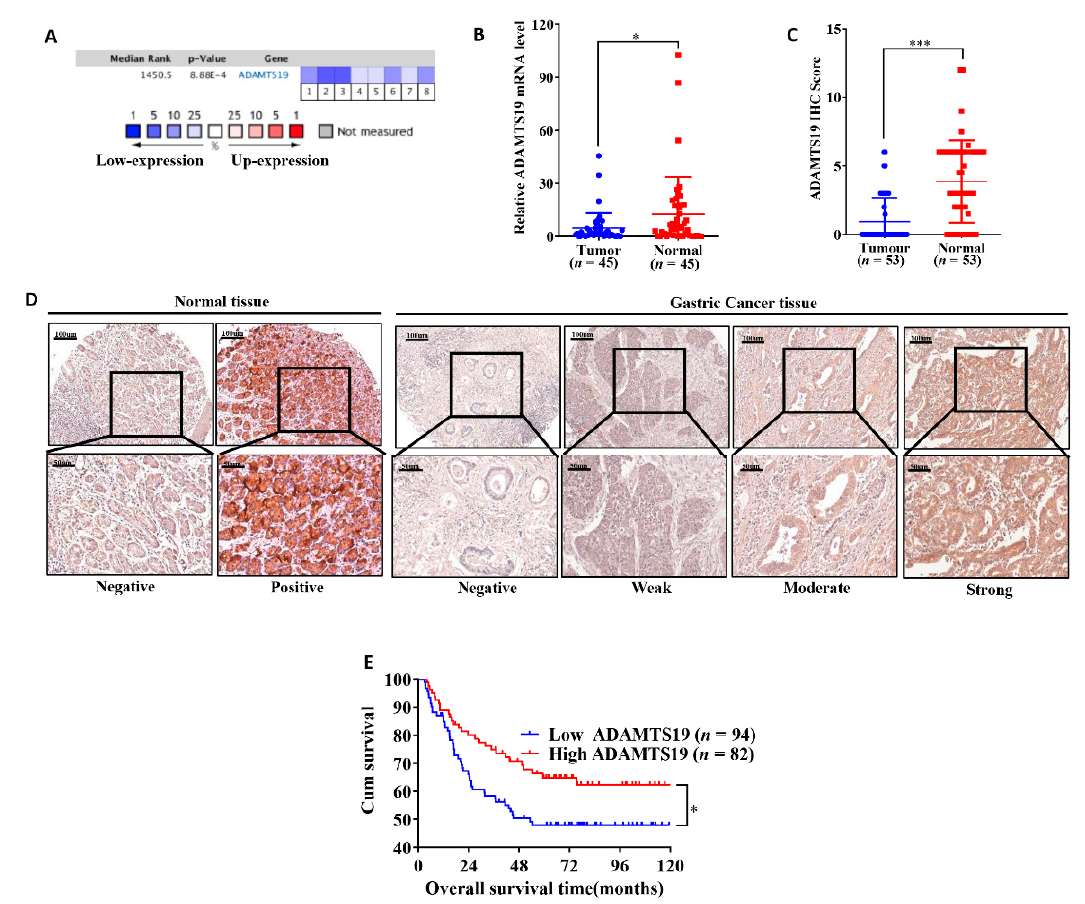
Figure 1. ADAMTS19 is downregulated in gastric cancer (GC). ( A ) Oncomine analysis revealed that ADAMTS19 mRNA expression levels are lower in tumor tissue than in normal tissue by meta-analysis. The intensity gene expression indexed with the color code bars, the median rank is used to demonstrated the gene rank in each analysis. ( B ) Quantitative real-time polymerase chain reaction (qRT-PCR) on 45 paired samples showed that ADAMTS19 mRNA expression levels were lower in tumor tissue than in adjacent normal tissue. ( C ) Immunohistochemistry (IHC) analysis of 53 paired samples showed that ADAMTS19 expression was lower in tumor tissue than in adjacent normal tissue. ( D ) Representative IHC images of tumor and adjacent normal tissue. ( E ) High ADAMTS19 expression predicted better overall survival than low ADAMTS19 expression in GC patients (the best cutoff score of 5.5 was obtained using X-tile). The data are presented as means ± standard deviations. * p < 0.05; *** p < 0.001.